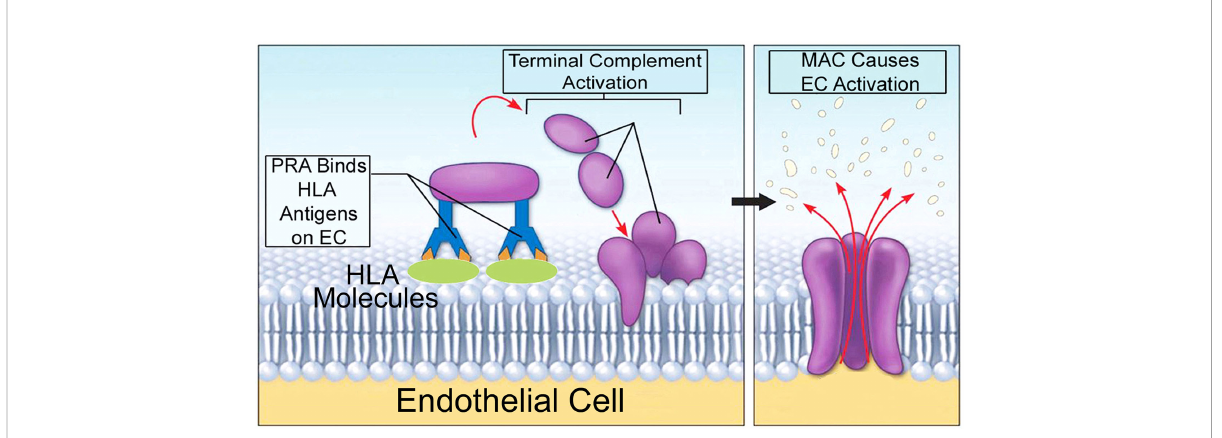
FIGURE 3 A model for autologous alloantibody-induced MAC assembly. 'High' panel reactive antibody (PRA) sera is obtained from transplant candidates and contain high titers of alloantibodies binding to many HLA speci fi cities. PRA mediates binding of donor speci fi c alloantibody to surface MHC I/II molecules on human ECs. This activates complement components within PRA sera, causing terminal activation of the classical complement pathway and formation of non-cytolytic MAC on target ECs. Human-derived MAC on human ECs causes EC activation without inducing cell